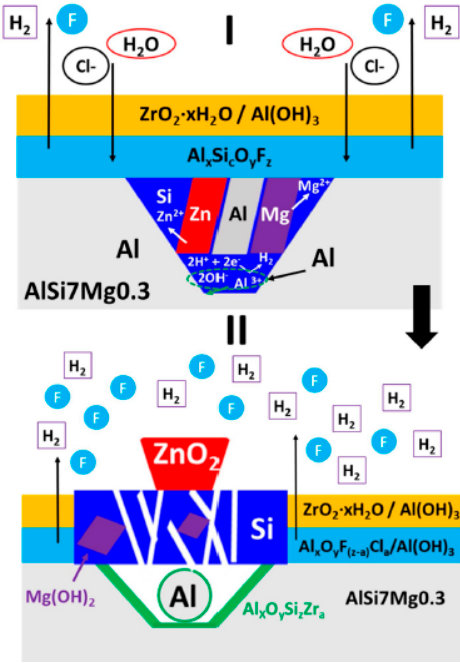
Figure19. CorrosionrateforcoatedanduncoatedA356.0substratesafter120himmersionasdetermined Figure 19. Corrosion rate for coated and uncoated A356.0 substrates after 120 h immersion as by weight loss experiments. Reprinted with permission of [108]. determined by weight loss experiments. Reprinted with permission of [108].